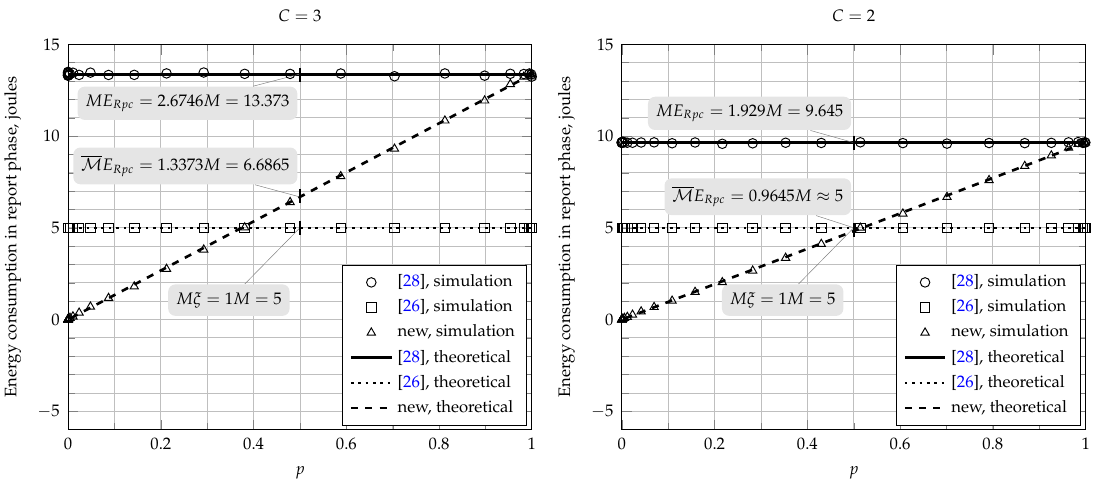
Figure 4. Energy consumption during the report phase for M = 5, γ SU = − 5 dB and E = ξ =